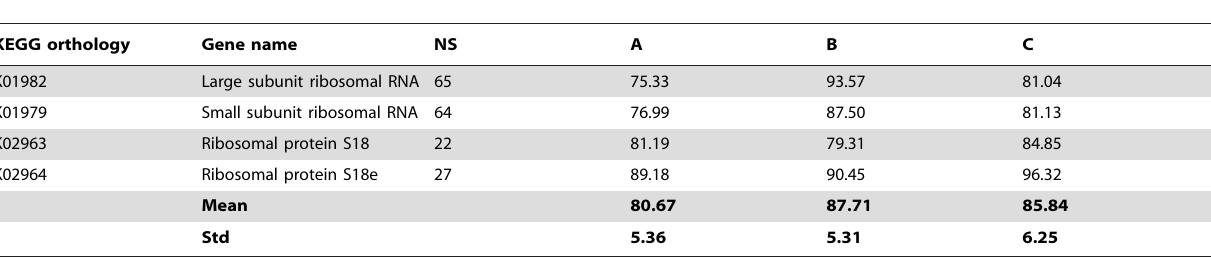
Table 4. Similarity scores for ribosomal protein genes and